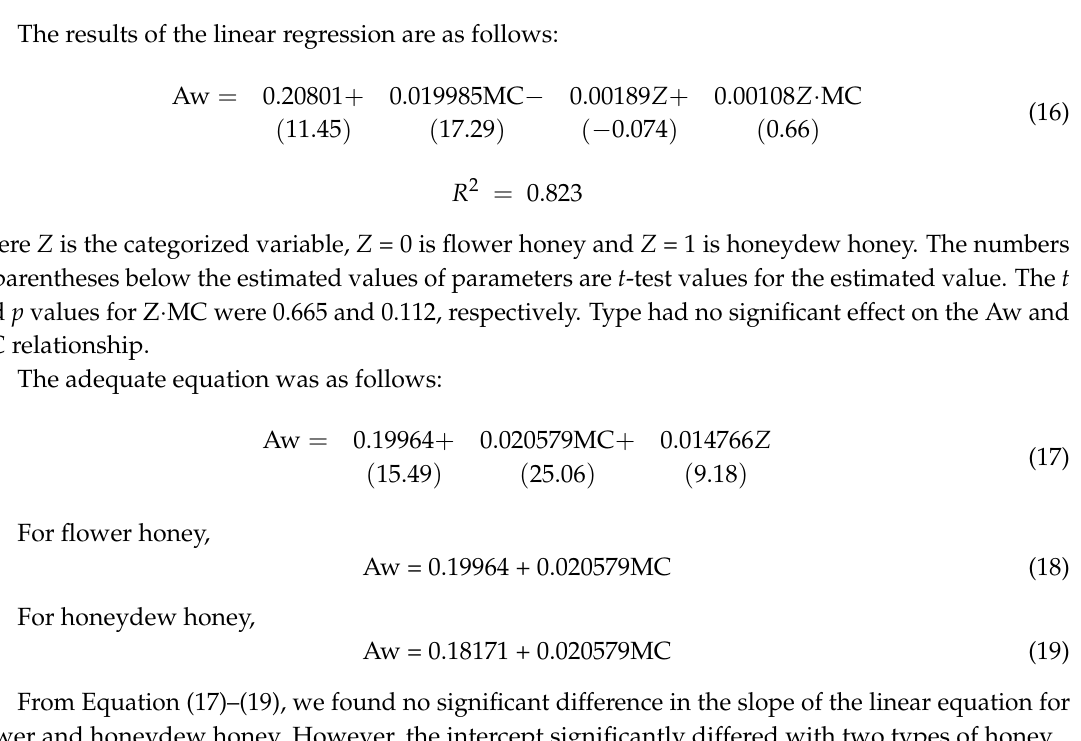
Figure 6. The relationship between water activity (Aw) and moisture content (MC) of flower and honeydew honey in Slovenia [5].